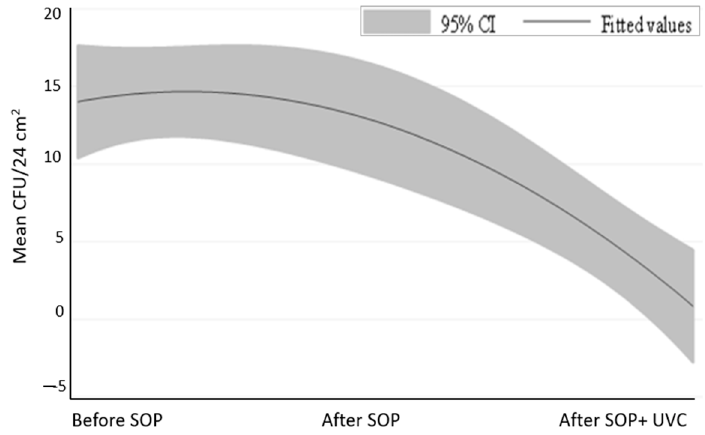
Figure 2. Prediction plot of quadratic regression model with [95% CI]. TVC (variable employee) and type of treatment (independent variable).